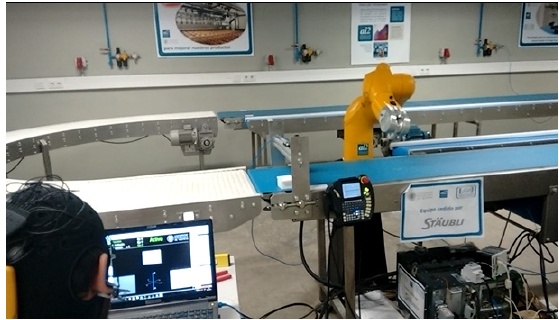
Figure 14. SSVEP BCI c ontrol of the Stäubli robotic arm.